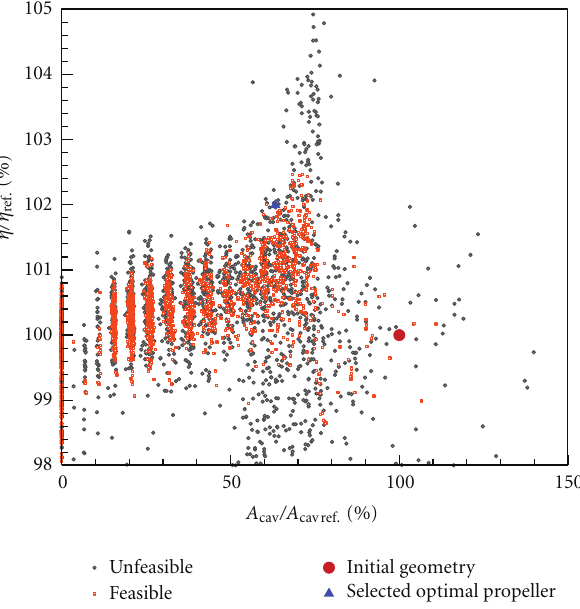
Figure 8: Pareto designs with preliminary (red) and final (blue) propellers numerical